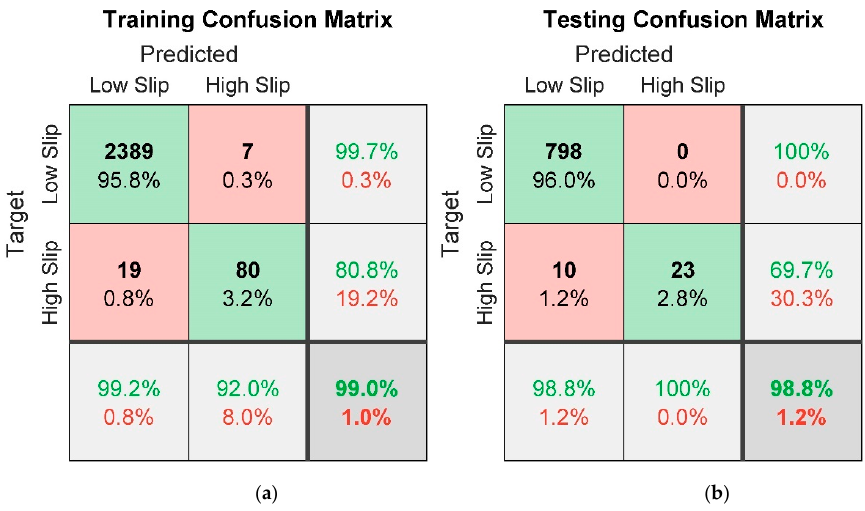
Figure 9. Confusion matrix for training ( a ) and testing ( b ) of the slippage classifier.